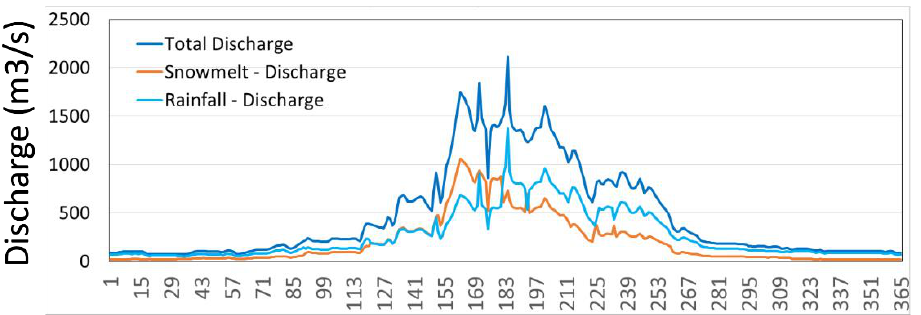
Figure 4. Averaged modeled daily discharge (1991–2008) at Kasol showing snowmelt-induced discharge and rainfall-induced discharge.